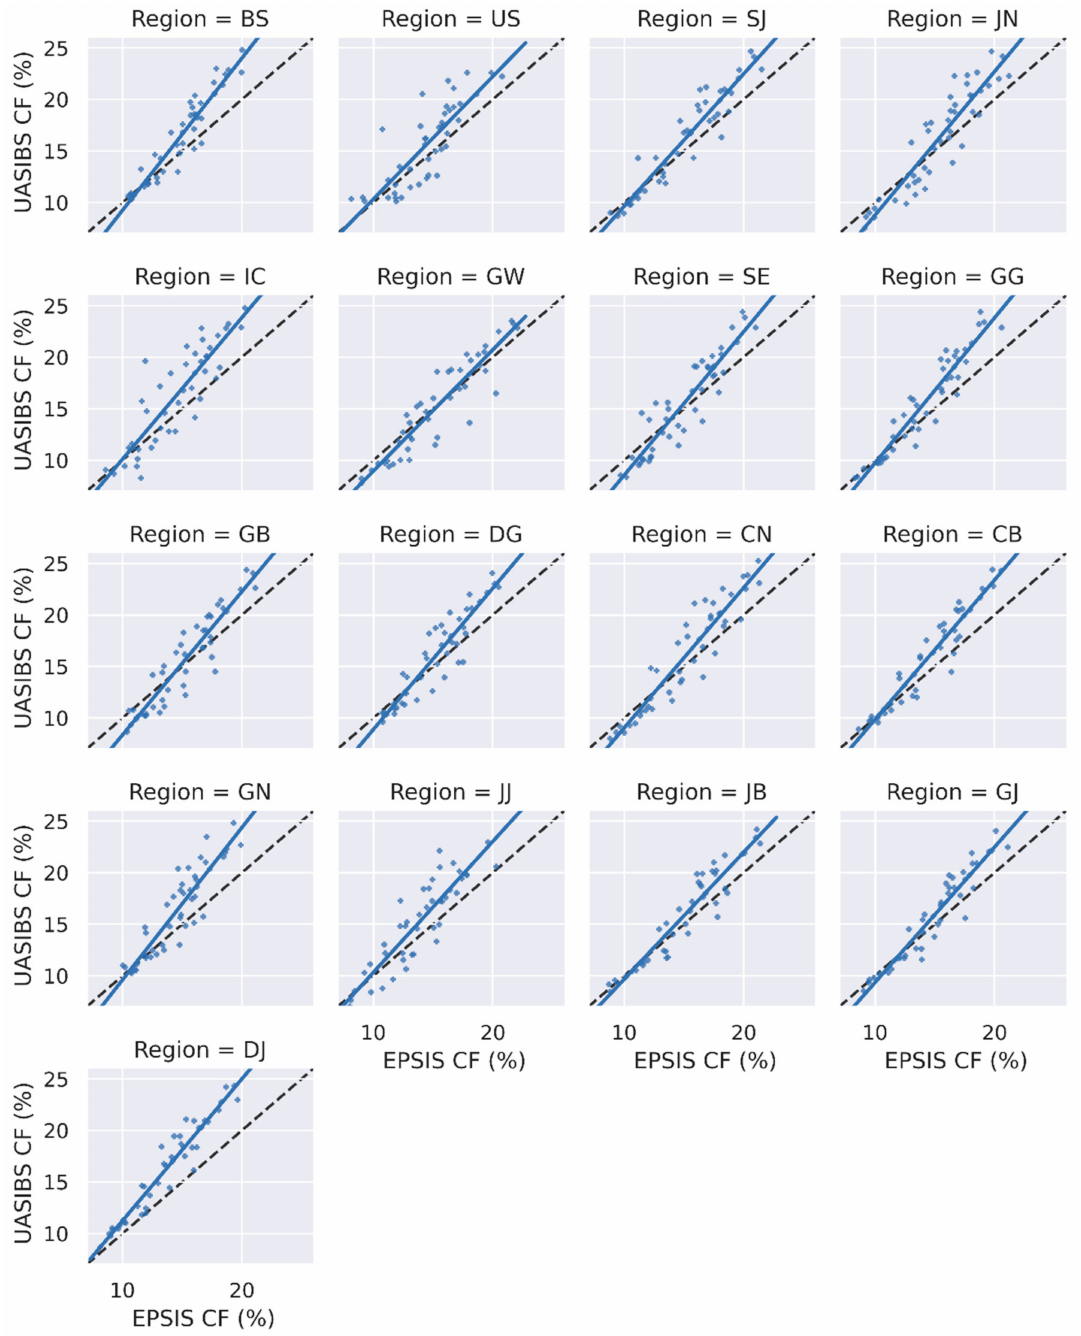
Figure 14. Same as Figure 12, but distributed for each administrative division in